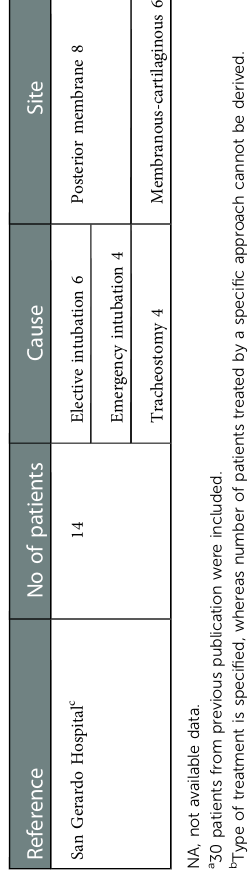
In the last three years, 14 patients with post-intubation ITIs were referred to the Department of Thoracic Surgery of our tertiary centre (San Gerardo Hospital, Monza, Italy). The injury was due to endotracheal tube mispositioning in 10 patients and emergency tracheotomy in 4 patients. It was along the tracheal posterior membrane in 8 cases (57%) and at the tracheal membrane- cartilaginous junction in the remaining patients. 4 lacerations were classi fi ed as level II, 9 as IIIA, 1 as IIIB. Upon multidisciplinary discussion, we have successfully treated all the patients, through conservative or endoscopic treatment, depending on patients ’ clinical and respiratory conditions, according to the in-hospital protocol reported in Figure 1 : 4 patients (level II) were conservatively treated, 10 patients (9 IIIA and 1 IIIB) were endoscopically managed. The conservative treatment consisted of endotracheal tube proper positioning and observation. On the other hand, the endoscopic treatment consisted of n-SEMS placement through rigid bronchoscopy, within 72 h from detection of ITIs; 30-day morbidity and mortality rates were null, and the stent was removed 4 – 6 weeks later without complications. All the injuries were completely healed at 1-month, without any relapse at 6-month follow-up. We were prompted to endoscopically handle patients with level III injuries, instead of adopting a conservative strategy, because of their respiratory conditions: all the patients were still ventilatory-dependent, due to primary lung failure, without a perspective of weaning in short time. In such setting, we strongly believe that a conservative treatment could be hardly feasible.